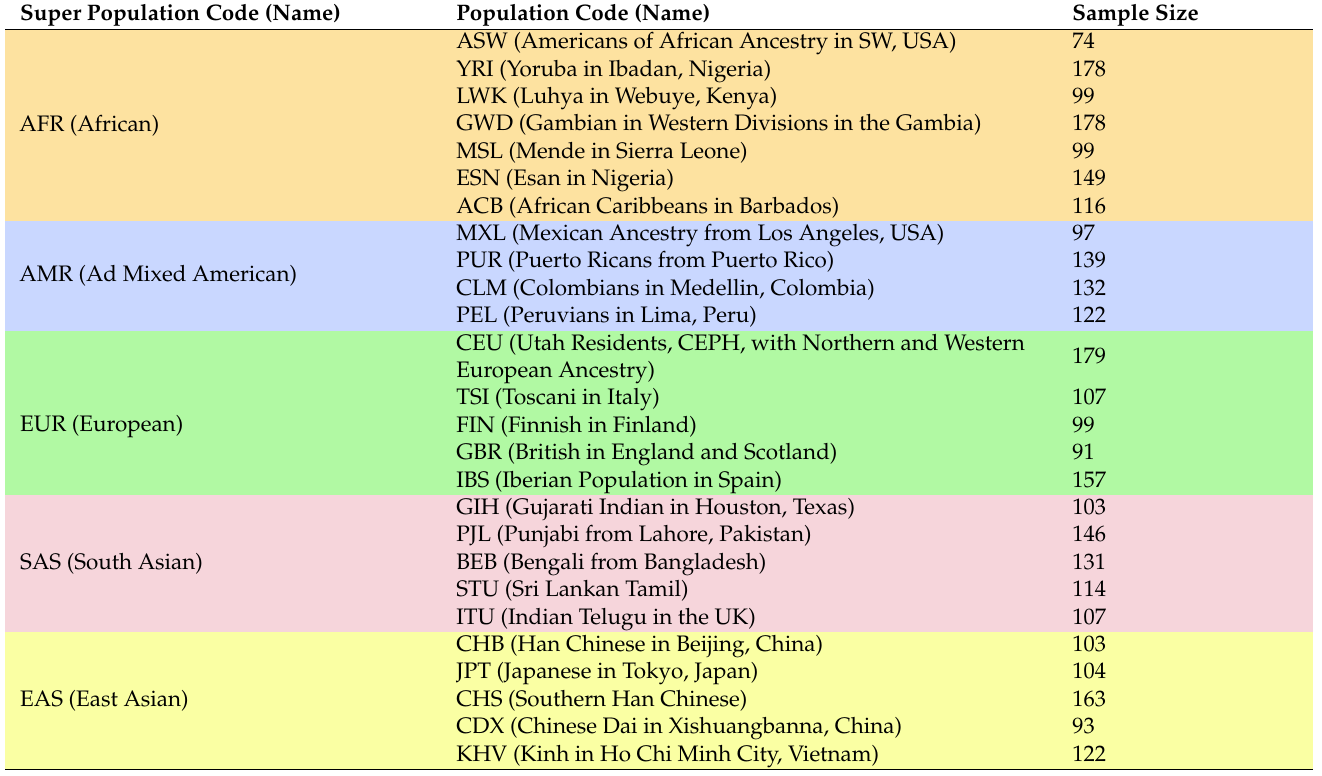
Table 1. Overview of the analyzed populations from the new panel of the 1KGP (~30-fold